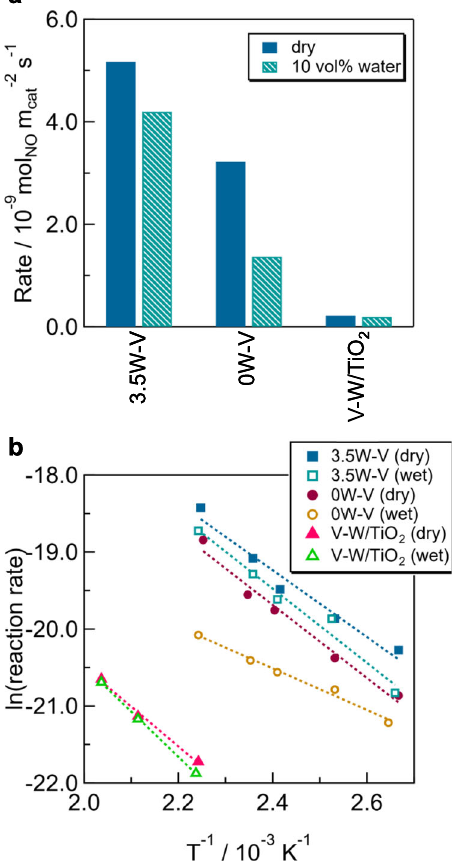
Fig. 5 Kinetic measurements for NH 3 -SCR. a Reaction rate per speci fi c surface area at 150 °C and b Arrhenius plots for 3.5W – V (W-substituted vanadium oxide), 0W – V (without tungsten), and V – W/TiO 2 (model of a conventional catalyst) at 150 °C under a dry condition and wet condition (10 vol% water).